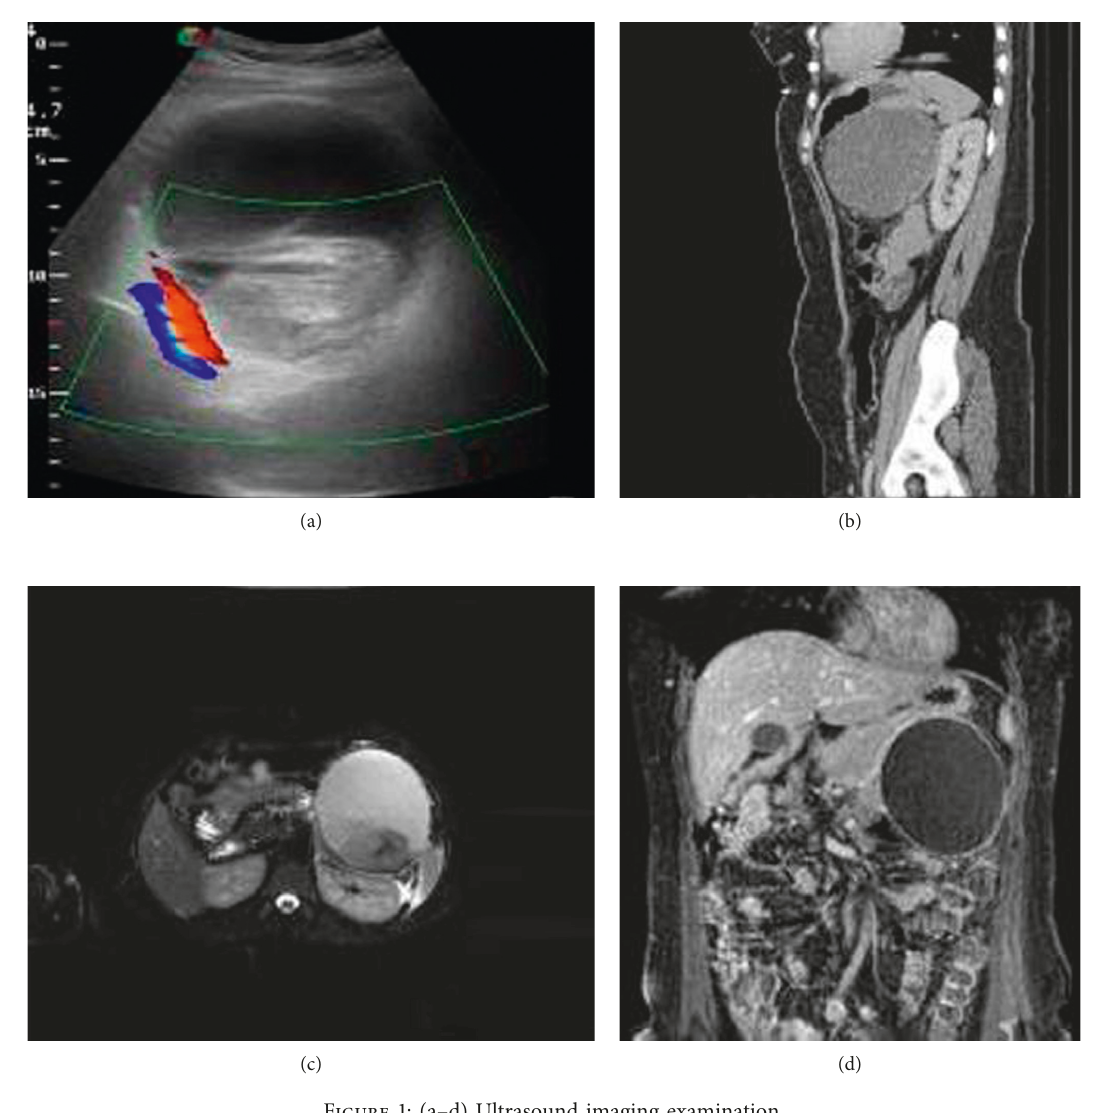
Figure 1: (a–d) Ultrasound imaging